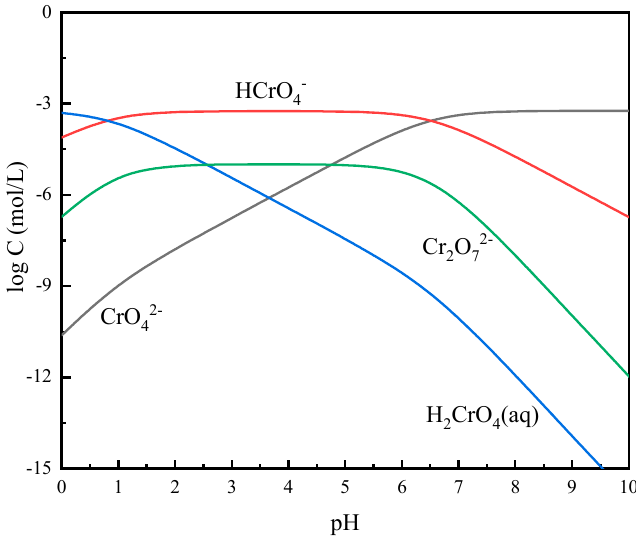
Figure 8. Species distribution diagram of 0.1 mol/L ferric chloride. Minerals 2020 , 10 , x FOR PEER REVIEW